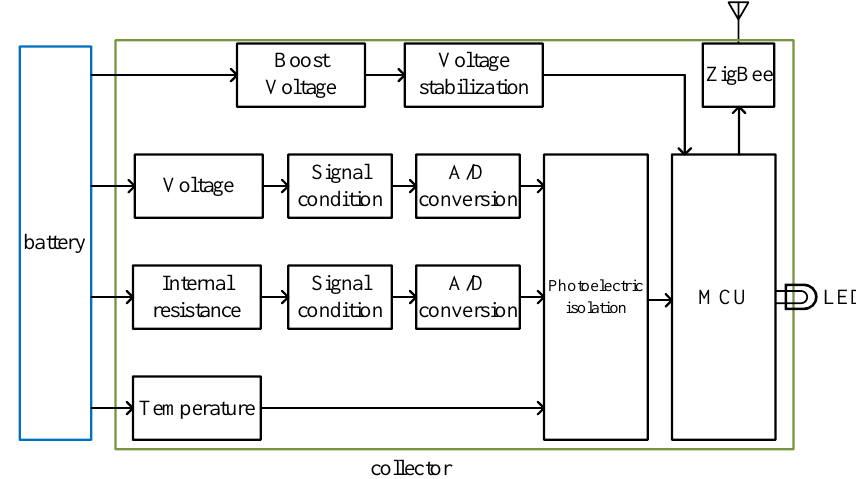
Figure 3. Structure diagram of the collector.